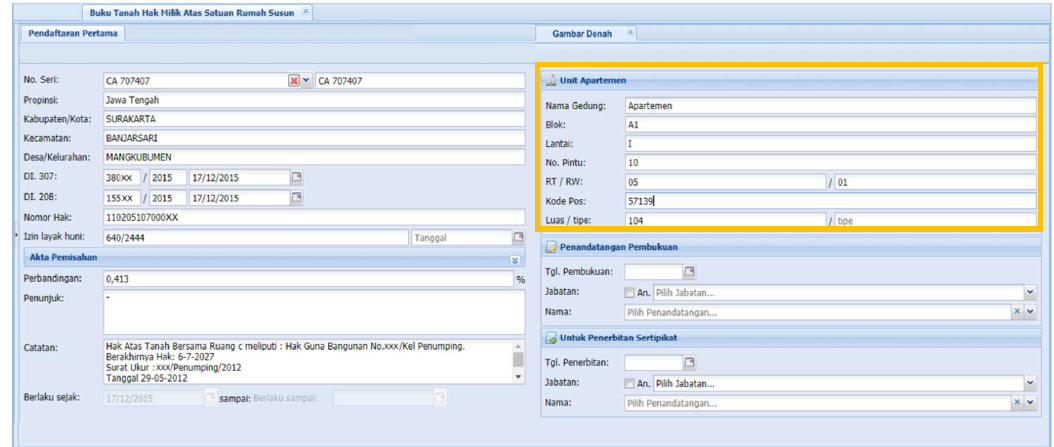
Figure 2. Information windows pertaining to the rights of apartment units; the information within the orange box specifies blocks, layers, apartment number, and area, while the spatial representation is only available for its common parcel.